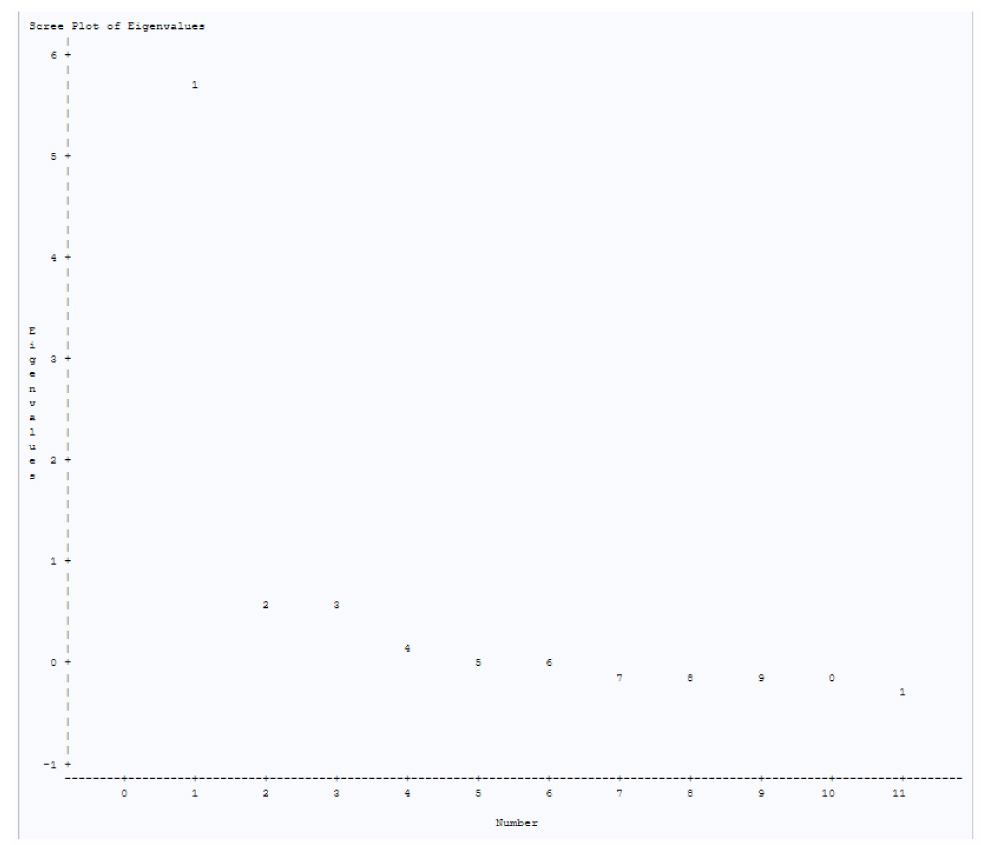
Figure 1. Scree plot of the eigenvalues for the determination of the number of factor groups. The scree plot is used to determine the number of factors to retain in an EFA or principal components to keep in a principal component analysis (PCA). The “elbow” of the scree plot is where the eigenvalues seem to level off and aids in the determination of the number of